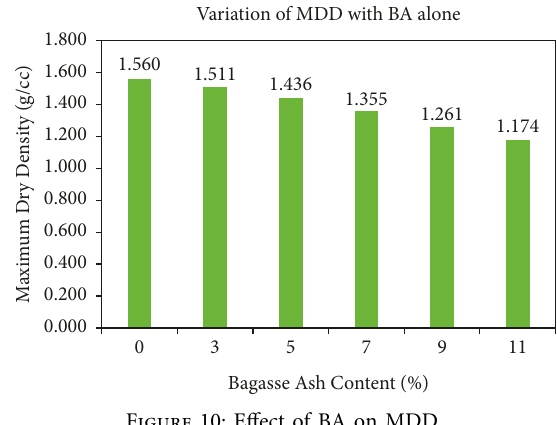
Figure 10: Effect of BA on MDD.